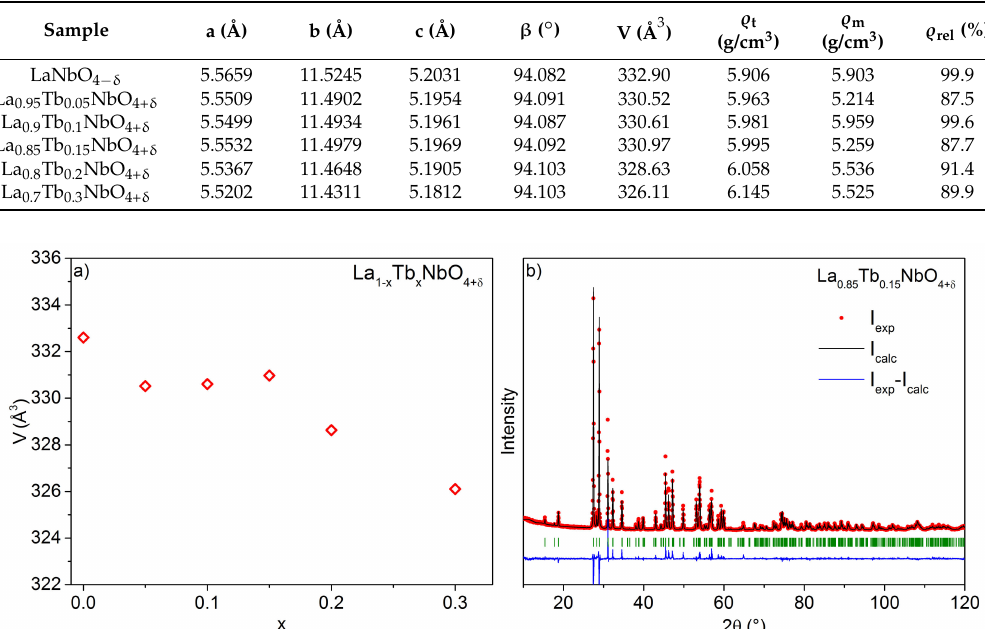
Table 1. Unit cell parameters and densities of La 1 − x Tb x NbO 4+ δ (x = 0.00, 0.05, 0.1, 0.15, 0.2, 0.3); (cid:36) t , (cid:36) m , and (cid:36) rel signify density calculated on the basis of unit cell parameters, density determined on the basis of Archimedes method, and relative density, respectively.